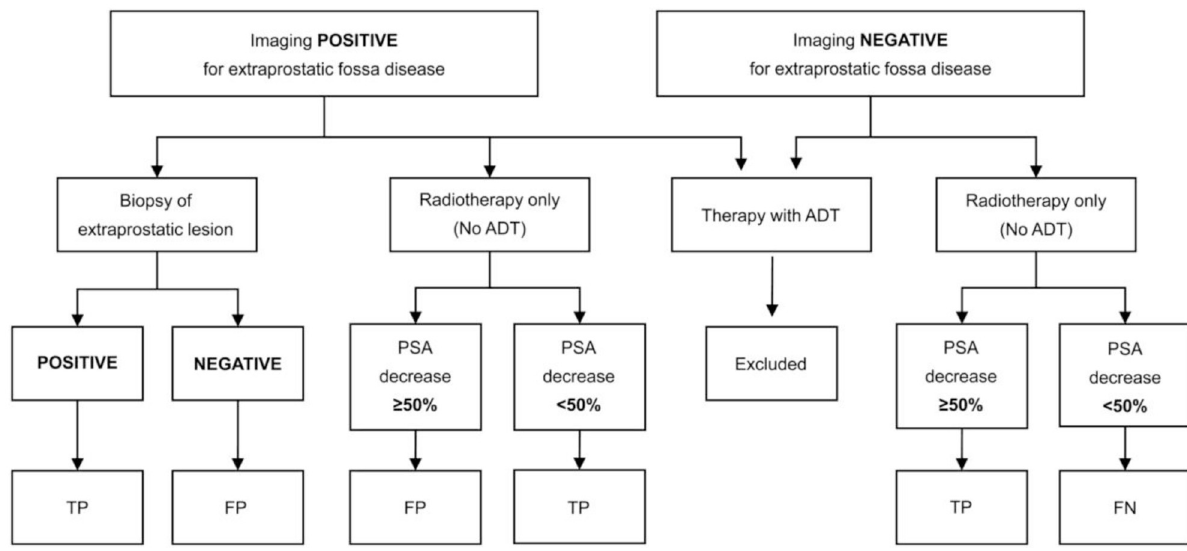
Fig 4. Example interpretation criteria for patients undergoing biopsy or radiotherapy (with and without systemic hormone deprivation therapy) image adapted from Emmett et al. [20].